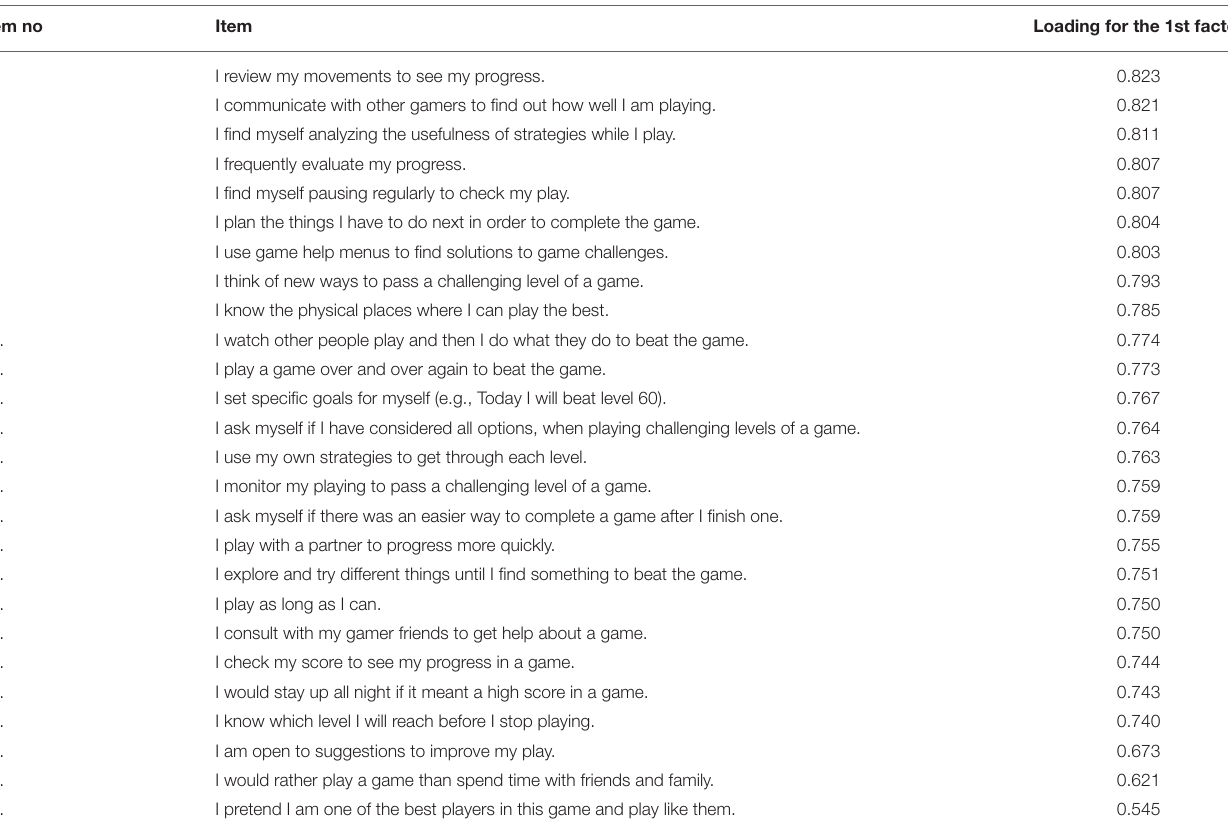
TABLE 2 | Exploratory factor analysis results for PMVGS scores using principal factors